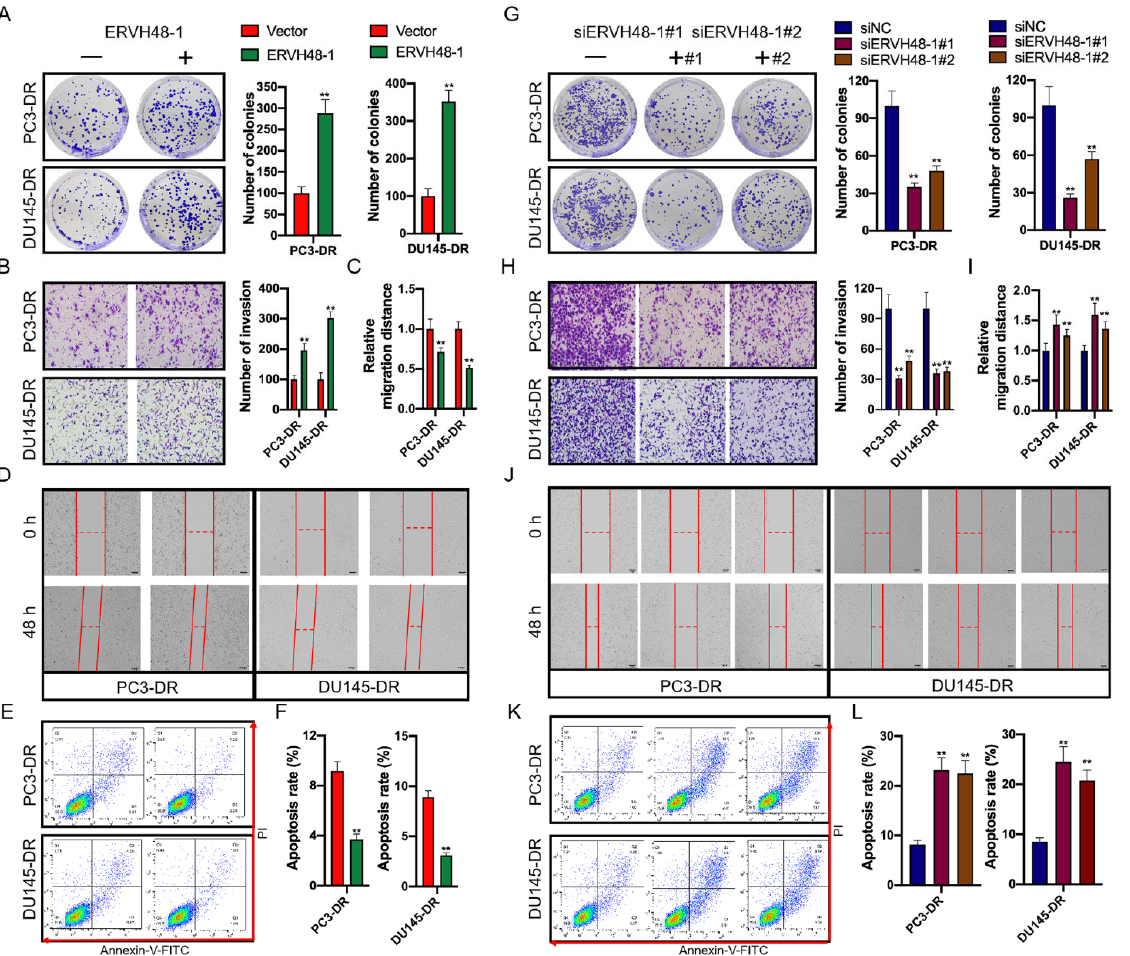
Figure 5. ERVH48 ‐ 1 promotes cell growth, invasion, and migration in PC3 ‐ DR and DU145 ‐ DR cells while inhibiting apoptosis. In ERVH48 ‐ 1 ‐ overexpressed PC3 ‐ DR and DU145 ‐ DR cells, clone formation, transwell, scratch ‐ wound, flow cytometry, and Western blot assays were used to detect cell proliferation ( A ), invasion ( B ), migration ( C , D ), and apoptosis ( E ). In ERVH48 ‐ 1 ‐ inhibition PC3 ‐ DR and DU145 ‐ DR cells, clone formation, transwell, scratch ‐ wound, flow cytometry, and Western blot assays were used to detect cell proliferation ( G ), invasion ( H ), migration ( I,J ), and apoptosis ( K ). ** p < 0.01. All experiments were repeated three times.